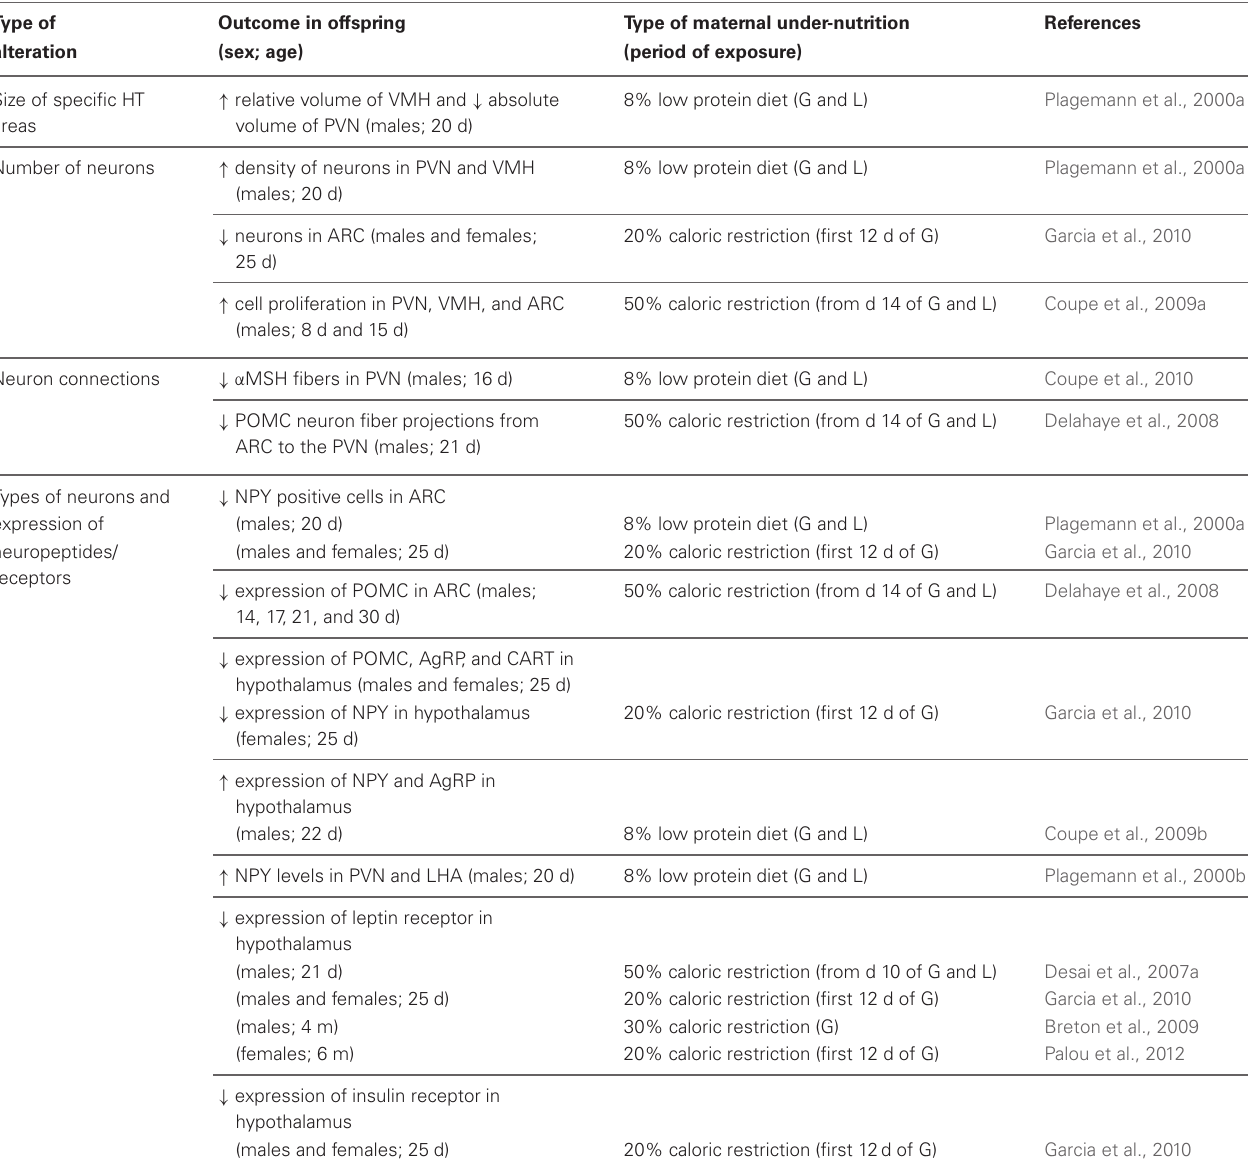
Table 2 | Hypothalamic reprogramming by maternal